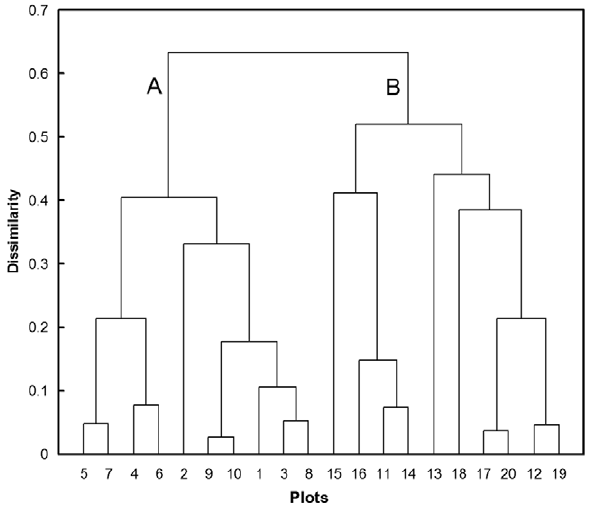
Figure 3. Cluster analysis dendrogram of the 20 plots investigated in the third